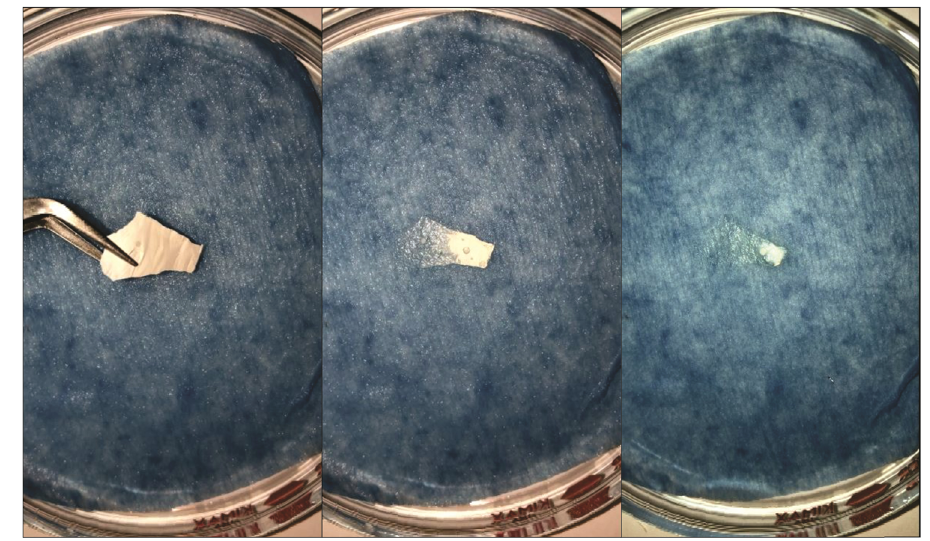
Figure 5: Evaluation of in vitro disintegration